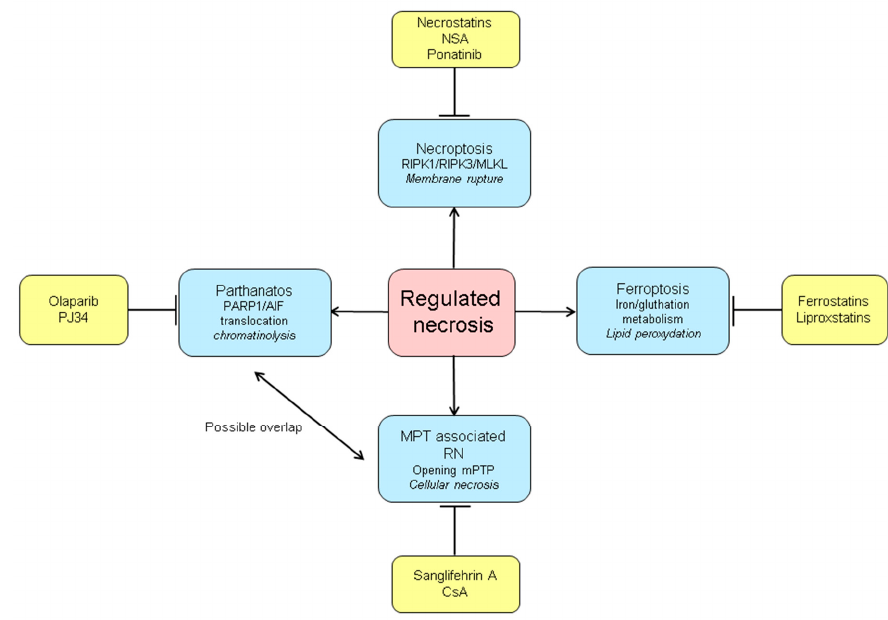
Figure 4. Programs of regulated necrosis and their inhibitors. RIPK1: receptor-interacting protein kinase 1; RIPK3: receptor-interacting protein kinase 3; MLKL: Mixed Kinase Domain-Like protein; MPT: mitochondrial permeability transition; mPTP: mitochondrial permeability transition pore; RN: regulated necrosis; CsA: cyclosporin A; PARP1: poly (ADP-ribose) polymerase-1; AIF: apoptosis-inducing factor.